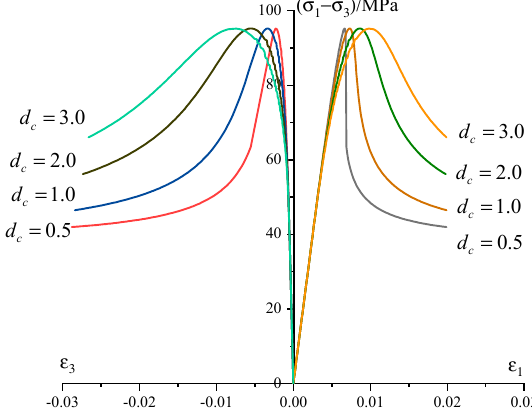
Figure 11. Sensitivity analysis on the parameter d c.